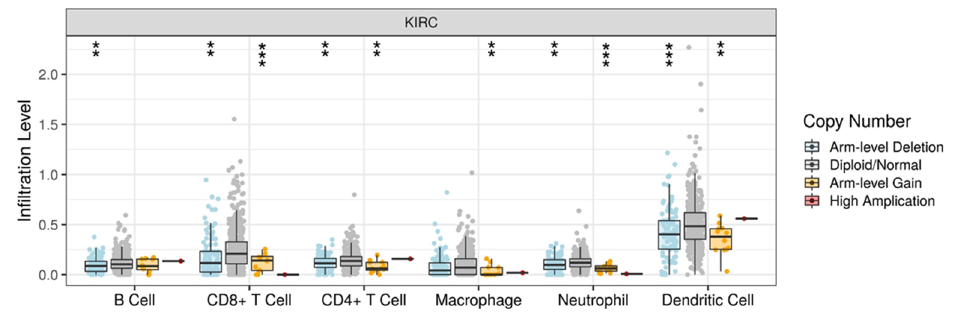
Figure 10. The copy number variation (CNV) of DLK2 affects the immune cells infiltration in ccRCC based on the TIMER analysis. The effect of DLK2 CNV on the B cells, CD8 + T cells, CD4 + T cells, macrophages, neutrophils, and dendritic cells in ccRCC. ** p < 0.01; *** p < 0.0001.